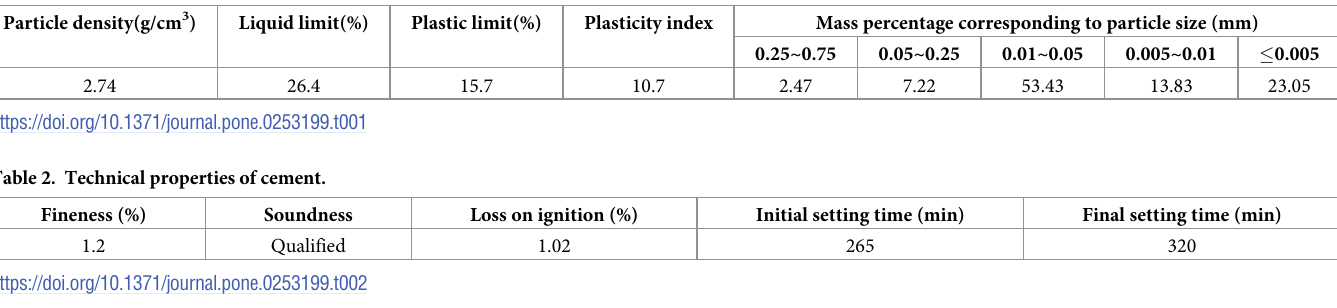
Table 1. Physical properties of loess.